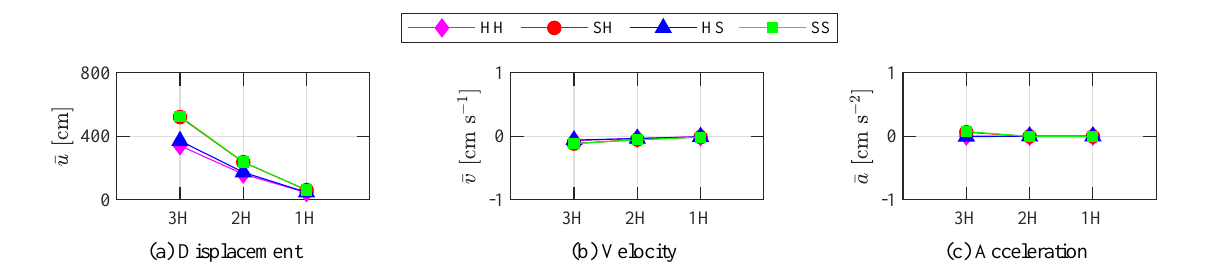
Figure 14. Mean wind-induced displacement, velocity, and acceleration of the FD system. 1H, 2H, and 3H are types of frame, and HH, SH, HS, and SS are types of added components of systems, which is indicated in Table 1 (along-wind).